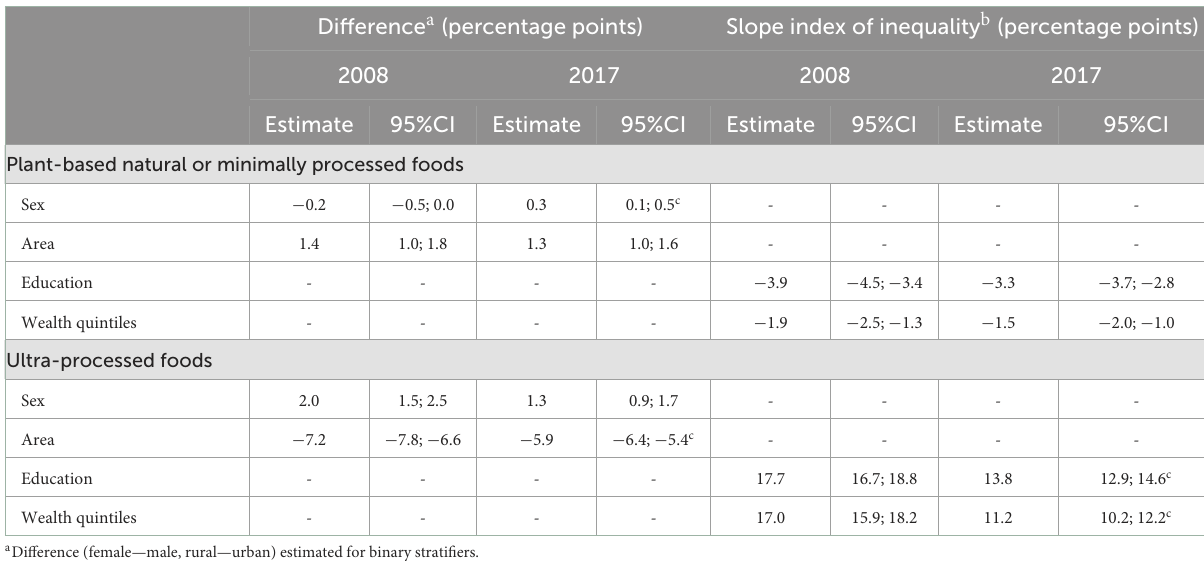
TABLE 1 Inequality measures for the set of plant-based natural or minimally processed foods and ultra-processed foods in 2008 and 2017. Difference a (percentage points)